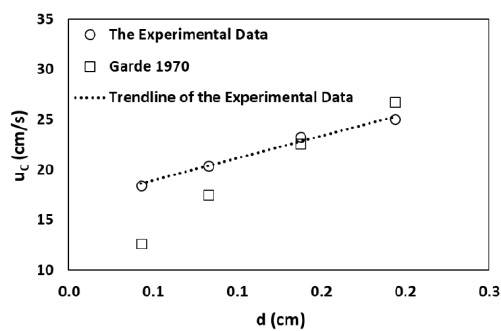
Figure 8. Threshold near-bed velocity vs. sediment particle size in comparison with results using equations developed by other researchers.